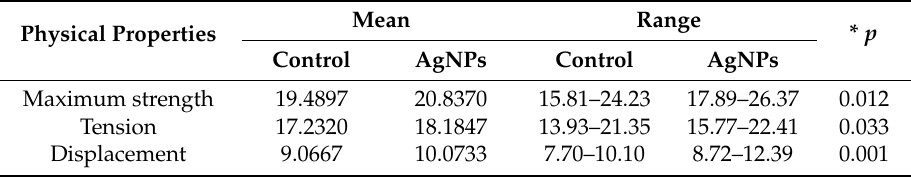
Table 2. Physical properties in orthodontic elastic modules.